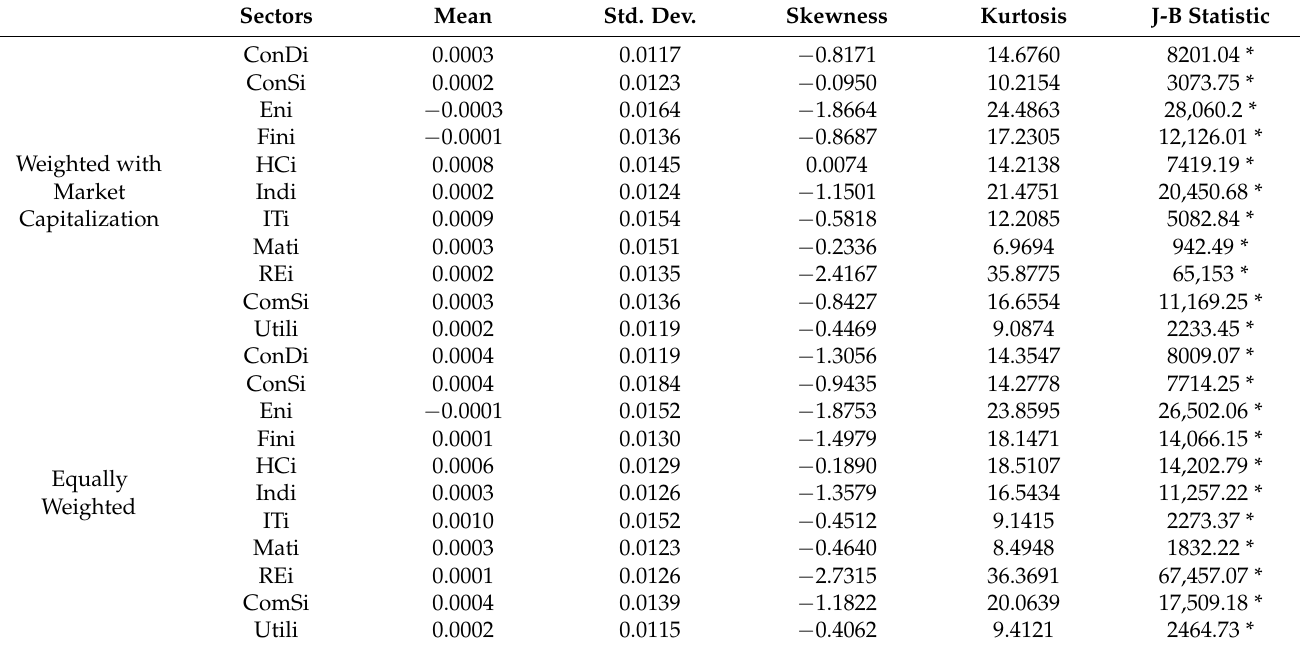
Table 2. Descriptive statistics of each of the Australian sector index returns.